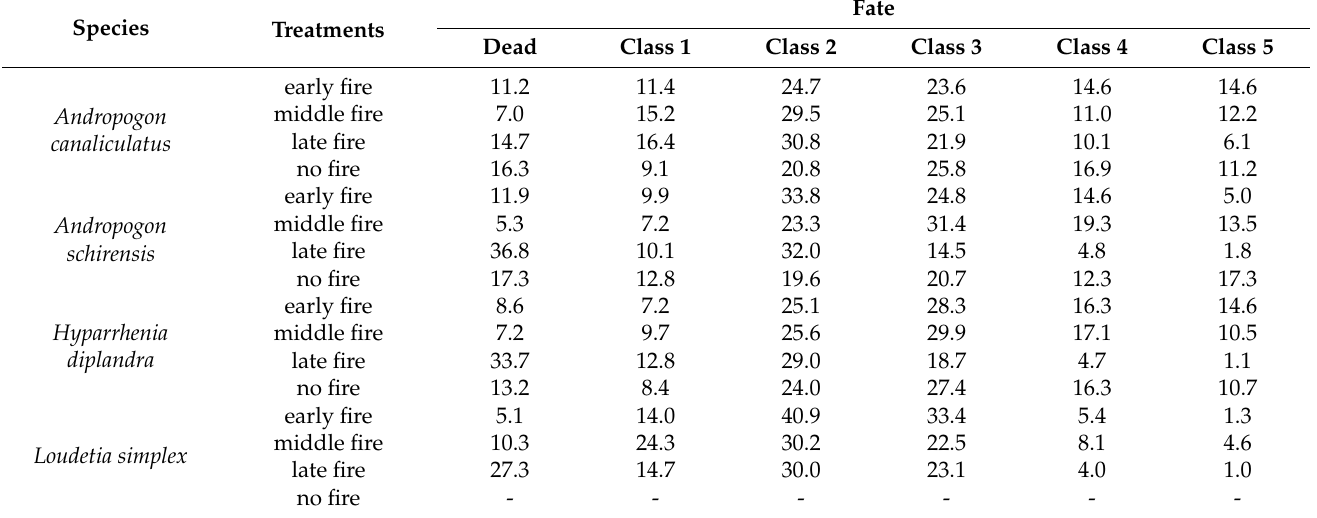
Table 3. Effect of the treatment × species interaction on the fate of grass individuals shown by the loglinear analysis. Table entries give the proportions (%) of transitions from individual initial states to six possible fates (dead, classes 1–5). The total number of individual in each fate by species and treatment was used in the